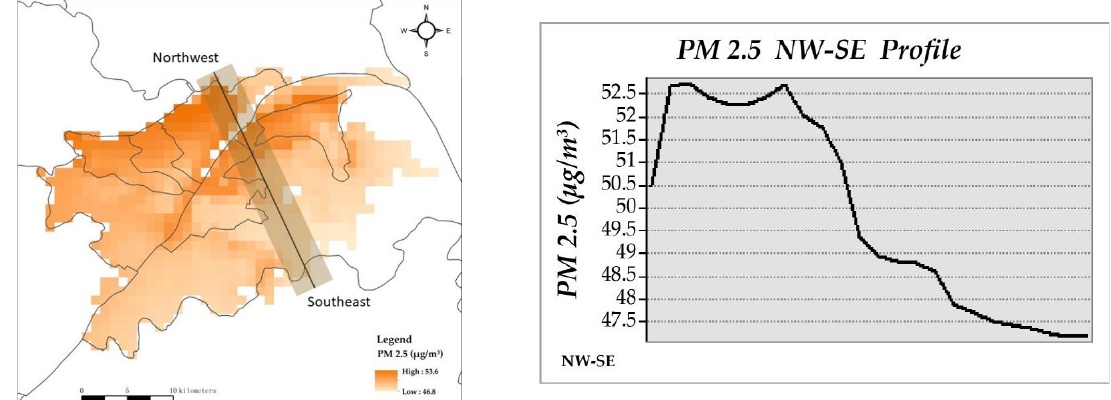
10 of 19 Figure 3. Mobile phone trajectories. The communities with the highest urban vibrancy values are the TongFu and Xiaojia urban communities. They are old towns in the Jiangan district and are located in a bustling commercial district near the famous Jianghan Pedestrian Street. These communities have extensive facilities, including those related to housekeeping, maintenance, food, and med- ical treatment, and the population size and flow are evident. The third one is Guanshan Village in the Hongshan district surrounded by several prestigious universities with a lively population flow. In all these communities with high urban vibrancy, old villages and new buildings are found with a series of urban regeneration projects and a transpor- tation facility that has substantially improved in recent years. 3.2. The Spatial Distribution of PM 2.5 and Land Surface Temperature The spatial distributions of PM 2.5 and surface temperature were then analysed. The spatial distribution of PM 2.5 presents a progressive decrease pattern from the northwest- ern to the southeastern area, with the highest and lowest values of 53.6 and 48.8 mg/m 3 , respectively (Figures 4 and 5). The mean values of PM 2.5 do not make a substantial dif- ference with Jiangan, Jianghan and Qiaokou in the western area along the Yangtze River, having slightly high values (Figure 6, the first number is the mean value of PM 2.5, and the second number is the stand deviation). The Hongshan urban district has the lowest PM 2.5 values that are generally attributed to the improvement effect from East Lake and abundant forest cover. Industrial development and several development zones, such as